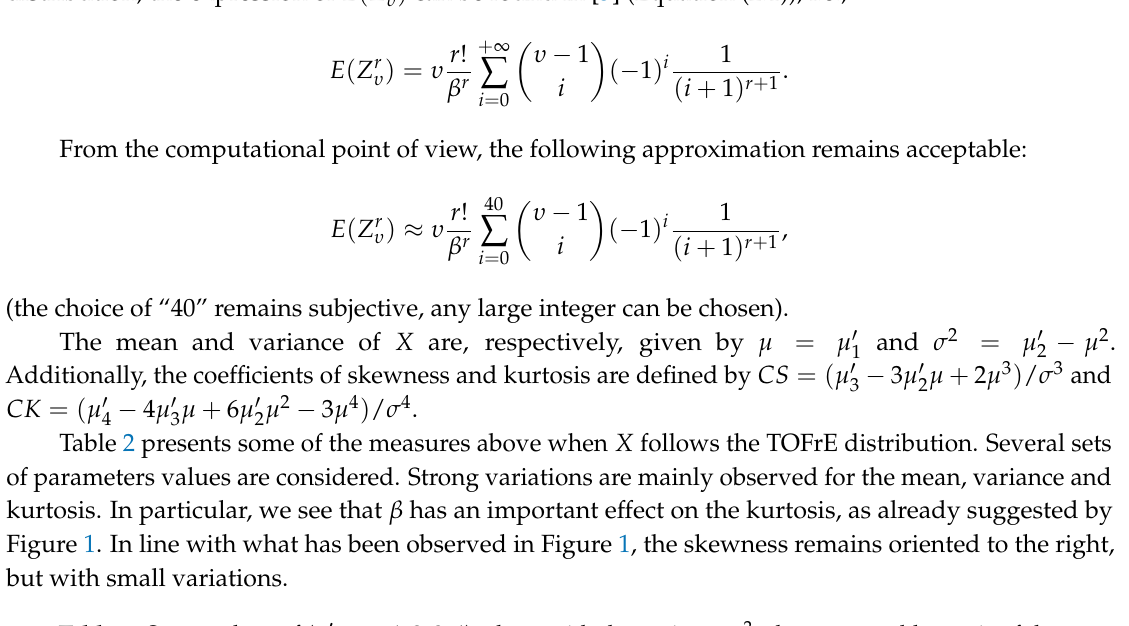
Table 2. Some values of ( µ (cid:48) r , r = 1,2,3,4), along with the variance σ 2 , skewness and kurtosis of the TOFrE